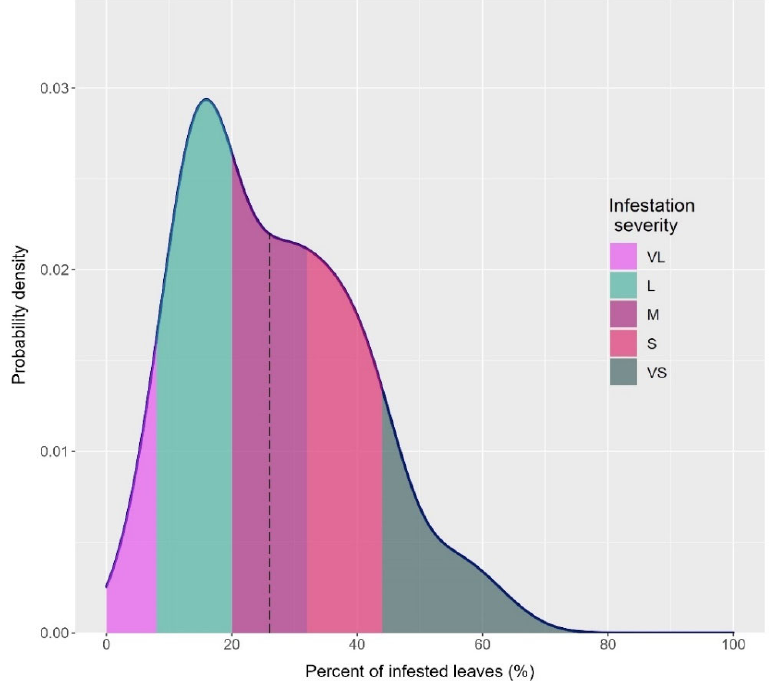
Figure 1. Frequency distribution of the 73 pomegranate accessions into classes of percent of infested leaves (PIL). Different colors indicate the infestation severity class as indicated in the color scale on the right-hand side (very light, VL: PIL ≤ 8%; light, L: 8% < PIL ≤ 20%; moderate, M: 20% < PIL ≤ 32%; severe, S: 32% < PIL ≤ 44; very severe, VS: PIL > 44%). The blue continuous line indicates the probability density function calculated with the Kernel density estimation method. The dashed vertical line indicates the PIL value (26%) adopted to center the middle bin (M). Bin size was 12%. The middle class was centered on the mean PIL value of the population (rounded at 26%). The bin size (12%) was then calculated dividing the observed maximum level of infestation (around 60%) by the number of classes desired. Therefore, the accessions were divided into the following classes of infestation severity: very light (VL: PIL ≤ 8%), light (L: 8% < PIL ≤ 20%), moderate (M: 20% < PIL ≤ 32%), severe (S: 32% < PIL ≤ 44) and very severe (VS: PIL > 44%). According to this classification, three accessions (4%) had very light (VL) infestation intensity (Gul-e-Shah Rose Pink, HP Collec., Speen Sacarin), whereas 37% of the accessions (27 accessions) had a low infestation severity (L) (Table 1). The infestation intensity was moderate (M) in 18 accessions (25%), severe (S) in 17 accessions (23%) and very severe (VS) in 8 accessions (11%) (Table